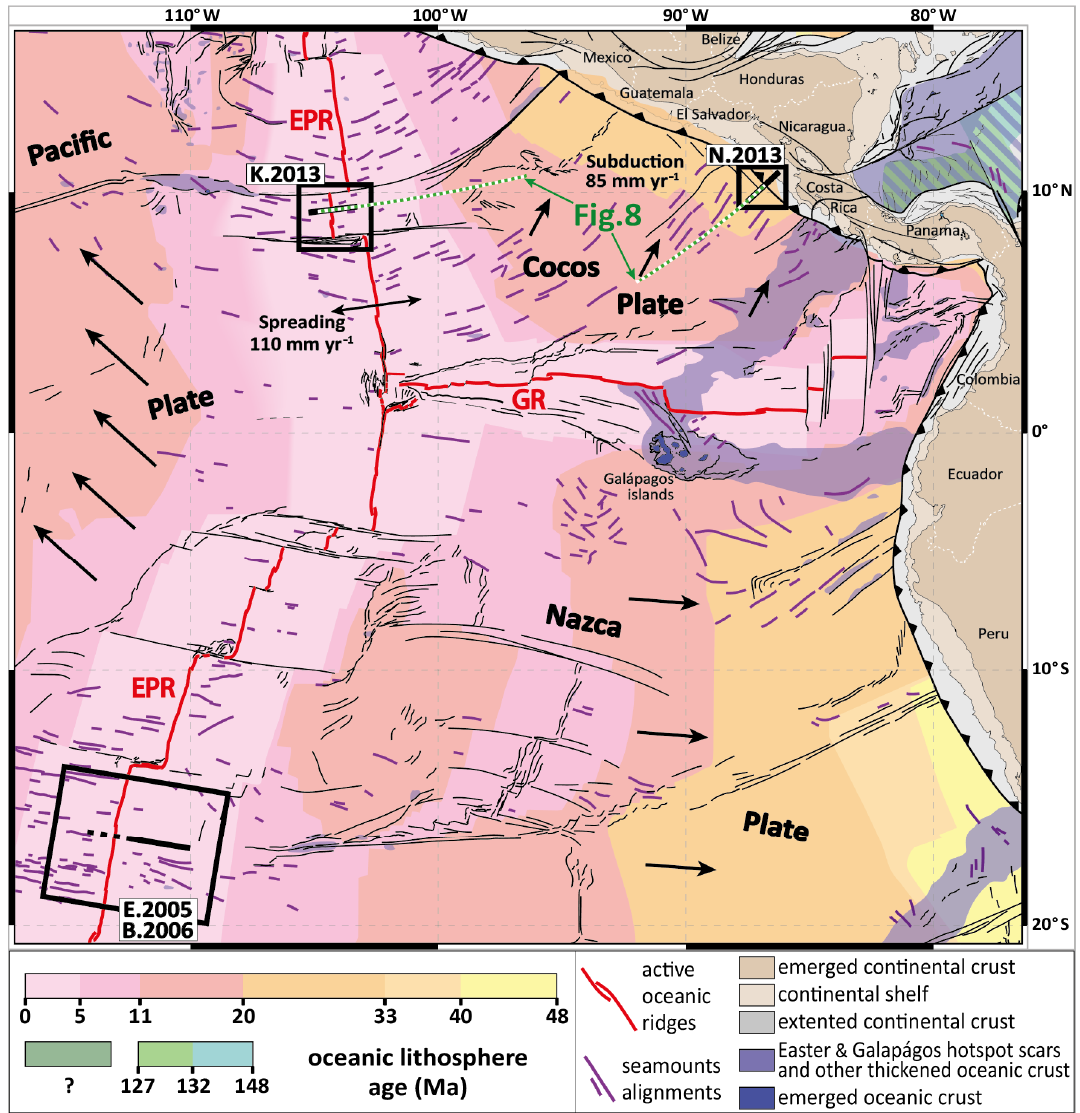
Figure 2. Synthetic map of the Eastern Pacific Ocean. Simplified map built from [5,6] and Google Maps. The spreading rate at the EPR is estimated to 11 cm·yr −1 for the Cocos Plate [7] and 10–15 cm·yr −1 for the Nazca Plate [8]. Large black arrows indicate plate motion direction. Magnetotelluric (MT) surveys: EPR = East Pacific Rise; GR = Galápagos Ridge. References: B.2006 = [2]; E.2005 = [1]; K.2013 = [7]; N.2013 = [3].